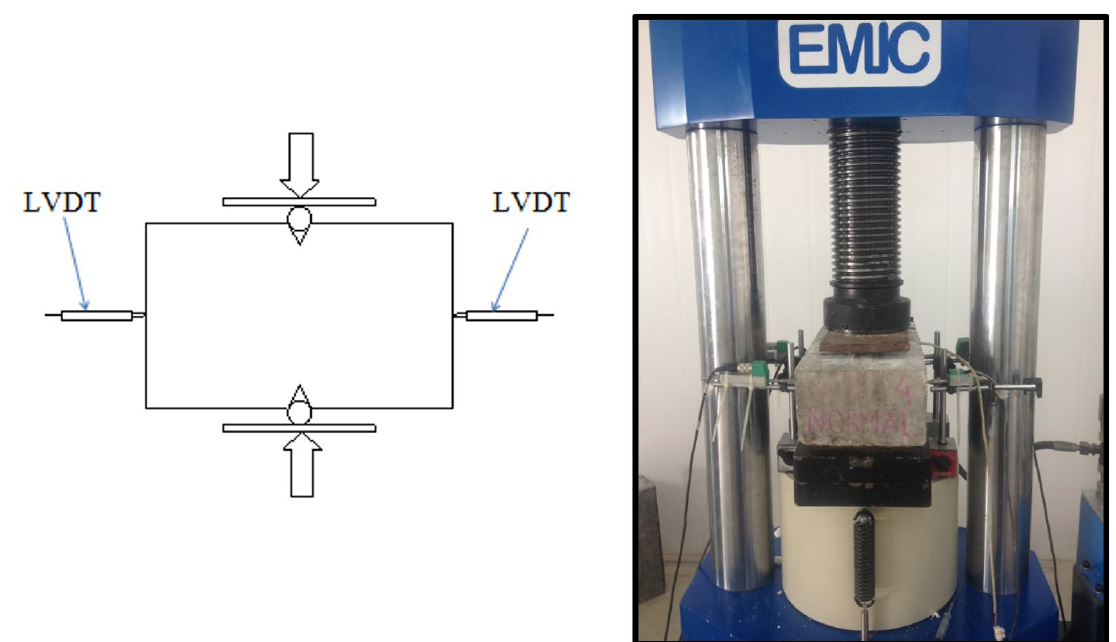
Figure 5. Instrumentation schematic of the push-off pre-cracking test specimens